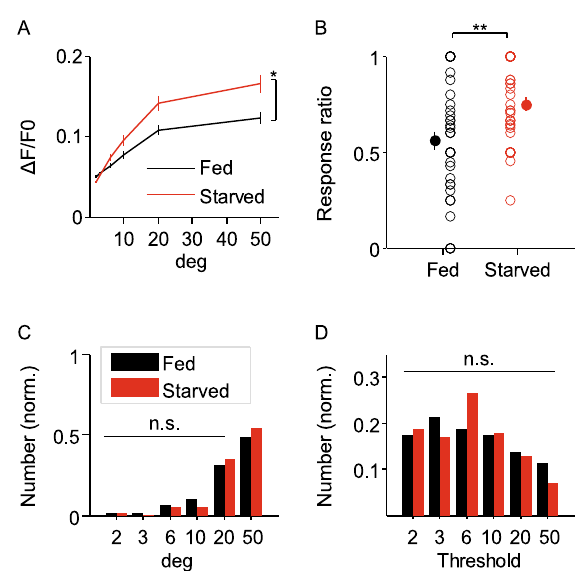
Figure 6. Gain modulation of SIN motion responses by brain state. (A) Summary of responses to moving dots from responsive somata between fed ( n = 132/247) and starved ( n = 170/231) larvae ( P = 0.0109, two-way ANOVA). (B) Summary of ratio of responsive neurons between fed ( n = 39 fi shes) and starved ( n = 39 fi shes) larvae ( P = 0.0024, Student ’ s t -test). (C) Distribution of tuned sizes remained unchanged in starved larvae ( n = 170/231) relative to fed control ( n = 132/247, P = 0.5246, Kolmogorov-Smirnov test). (D) Distribution of response sensitivity remained unchanged in starved larvae ( n = 170/231) relative to fed control ( n = 132/247, P = 0.9909, Kolmogorov-